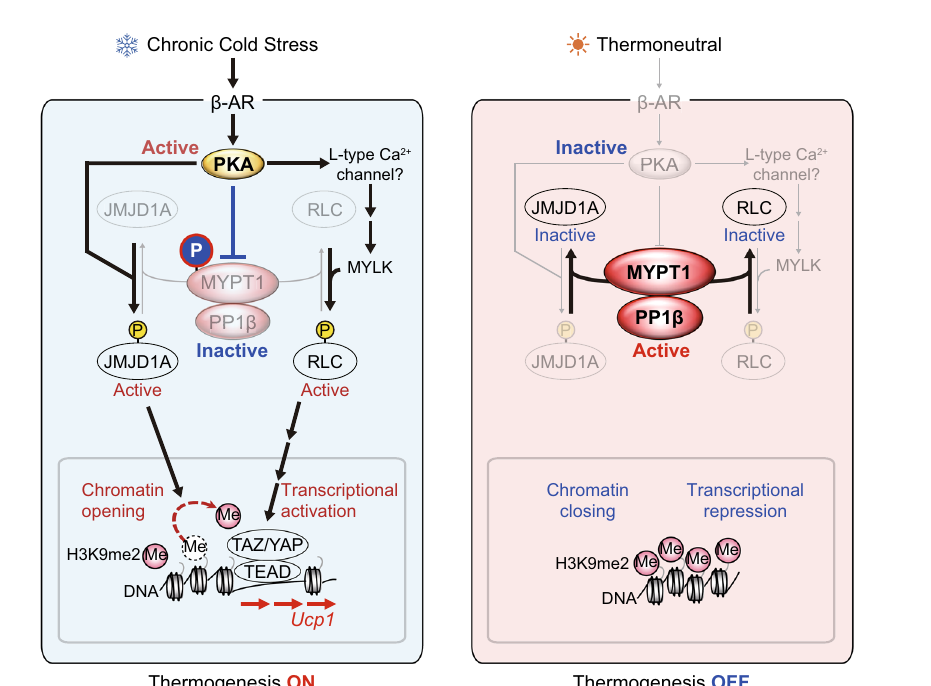
Fig. 6 | MYPT1-PP1 β -mediated mechanism for the regulation of thermogenic gene expressions in scWAT in cold or cold stress-free environment. In cold environment, while PKA is activated, MYPT1-PP1 β is inactivated through PKA- mediatedMYPT1phosphorylation,whichinturnef fi cientlyphosphorylatesJMJD1A